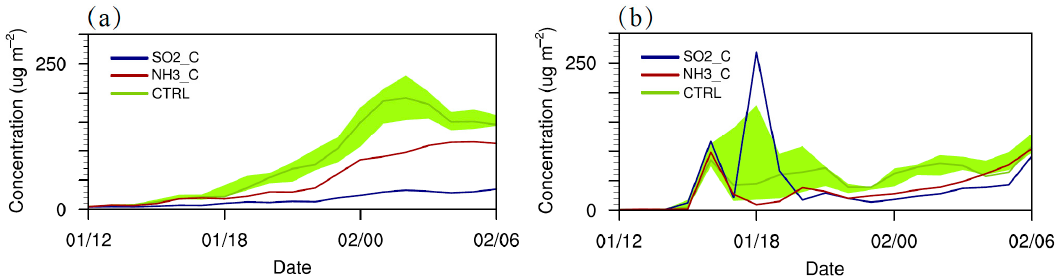
Figure 9. The time-series of area-averaged and vertically-integrated concentration of ( a ) SO (cid:2872)(cid:2870)(cid:2879) and ( b ) NH (cid:2872)(cid:2878) within the radius of 150-km from the vortex center in the CTRL, SO2_C and NH3_C run. The shaded area in green presents the spread of ensembles.